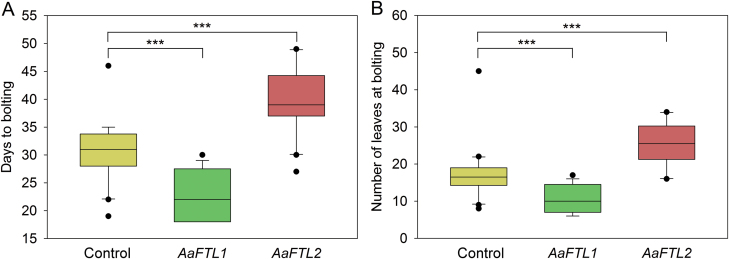
Transgenic expression of AaFTL1 and AaFTL2 in Arabidopsis. Box plots of the duration of the vegetative phase in days to bolting (A) and number of rosette leaves at bolting (B) of T1 plants containing pMDC160 (control, yellow), and of plants expressing the coding sequences of AaFTL1 (green) or AaFTL2 (red) under the constitutive 35S CaMV promoter. Box plots show the first, second, and third quartiles (the box), the 10th and 90th percentiles (the whiskers), and outliers as individual dots. Mann–Whitney U-tests were performed to test for significant differences between groups (***P<0.001; Bonferroni correction was applied with m=4 to the α of individual comparisons to obtain the indicated overall α values).